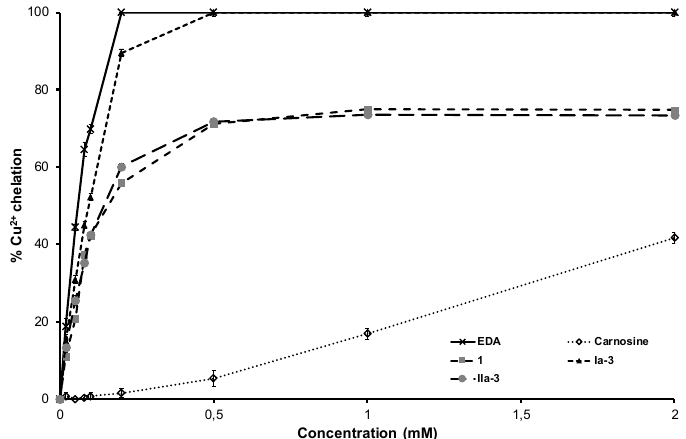
Figure 5. Evaluation of Cu 2+ ‐ chelating capacity of new HOPO ‐ diamine hybrids and references. Tested compounds (0–2 mM) were incubated with CuSO 4. 5H 2 O (120 μ M) in a 10 mM hexamine/HCl buffer containing 10 mM KCl (pH 5.0) for 10 min at rt. Murexide (50 μ M), used as a complexometric indicator reacting with remaining free Cu 2+ , was added and the mixture was incubated for additional 1 min at rt. The absorbance ratio A 485 /A 520 ( λ max of Cu 2+ /murexide complex: 485 nm and λ max of free murexide: 520 nm) provided remaining free Cu 2+ concentration with respect to calibration curves (A 485 /A 520 vs. Cu 2+ concentration). Knowing the total quantity of metal ions introduced in the reaction mixture (control conditions without tested product), percentage of Cu 2+ chelation by tested compounds was calculated by difference. Data are presented as means ± SEM of triplicates.